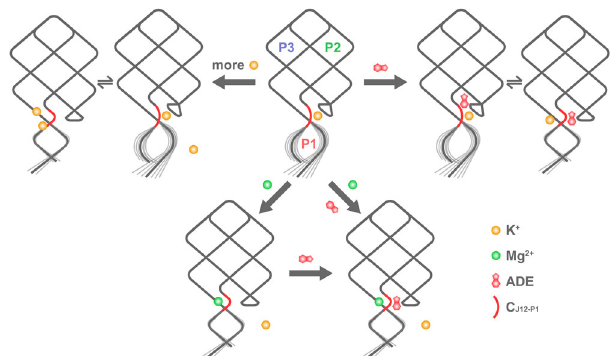
Fig. 9 Simple dynamic model for the structural transition of AARA (with or without ligand binding) in different ionic environment. Firstly, C J12-P1 adopts a loose state under the condition of low K + concentration. Secondly,